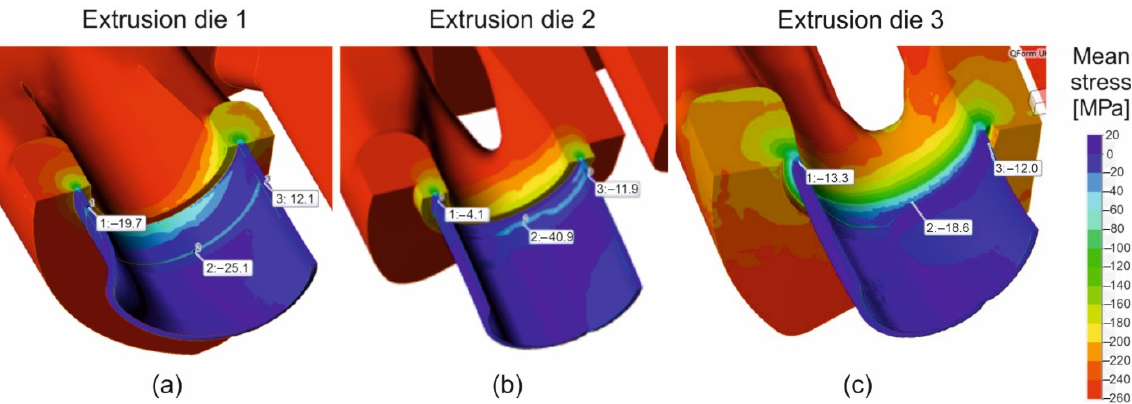
Figure 8. Distribution of mean stress during extrusion of tubes of Ø50 × 2 mm from 7021 aluminium alloy through porthole dies of different geometry—die 1 ( a ), die 2 ( b ) and die 3 ( c